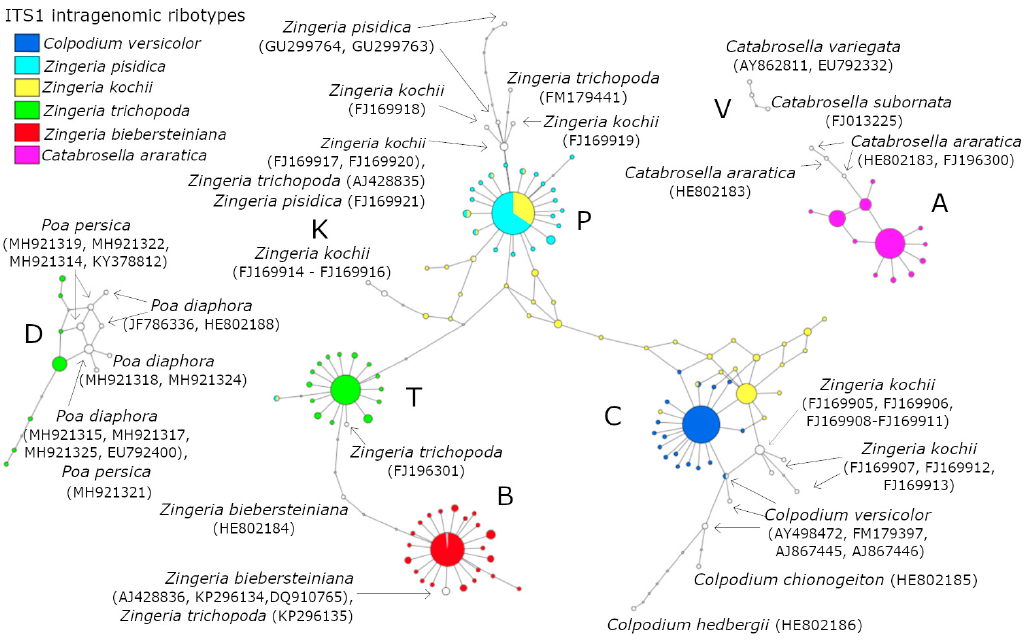
2 Figure 1. System of ITS1 ribotypes of Zingeria , Colpodium versicolor , and Catabrosella . The filled circles represent intragenomic ribotypes (A, B, C, D, K, P, T, and V), obtained via next-generation sequencing (NGS). The open circles represent sequences from